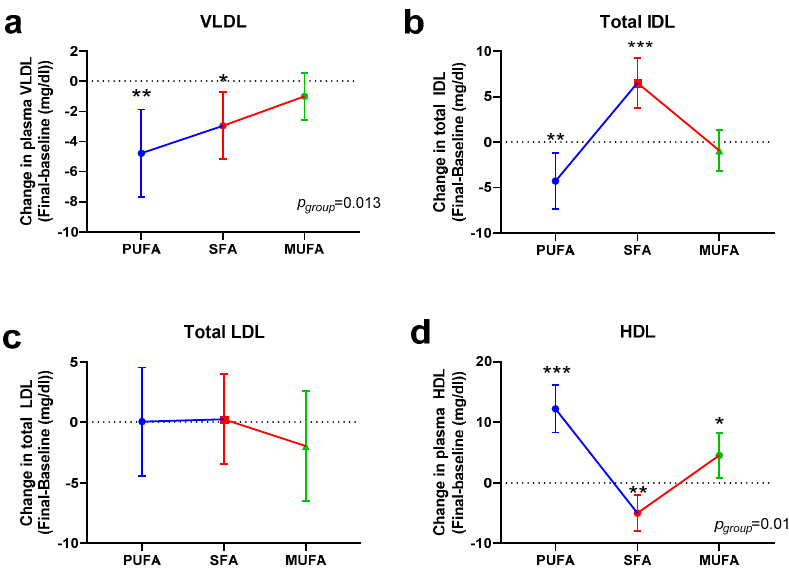
Figure 3. Changes in very low-density lipoproteins (VLDL, a ), intermediate-density lipoproteins (IDL, b ), low-density lipoproteins (LDL, c ), and high-density lipoproteins (HDL, d ) after 30 days of intervention with the di ff erent breakfasts. Data represent estimated treatment di ff erences (final-baseline) values and the 95% confidence interval (CI). Data derive from those women who completed the study ( n = 53). * represents di ff erences within the same group (final-baseline). * p < 0.050, ** p < 0.010, *** p < 0.001. Within-group di ff erences are indicated as p group . Further information is available in Table S2. Nutrients 2020 , 12 , x FOR PEER REVIEW 8 of 14